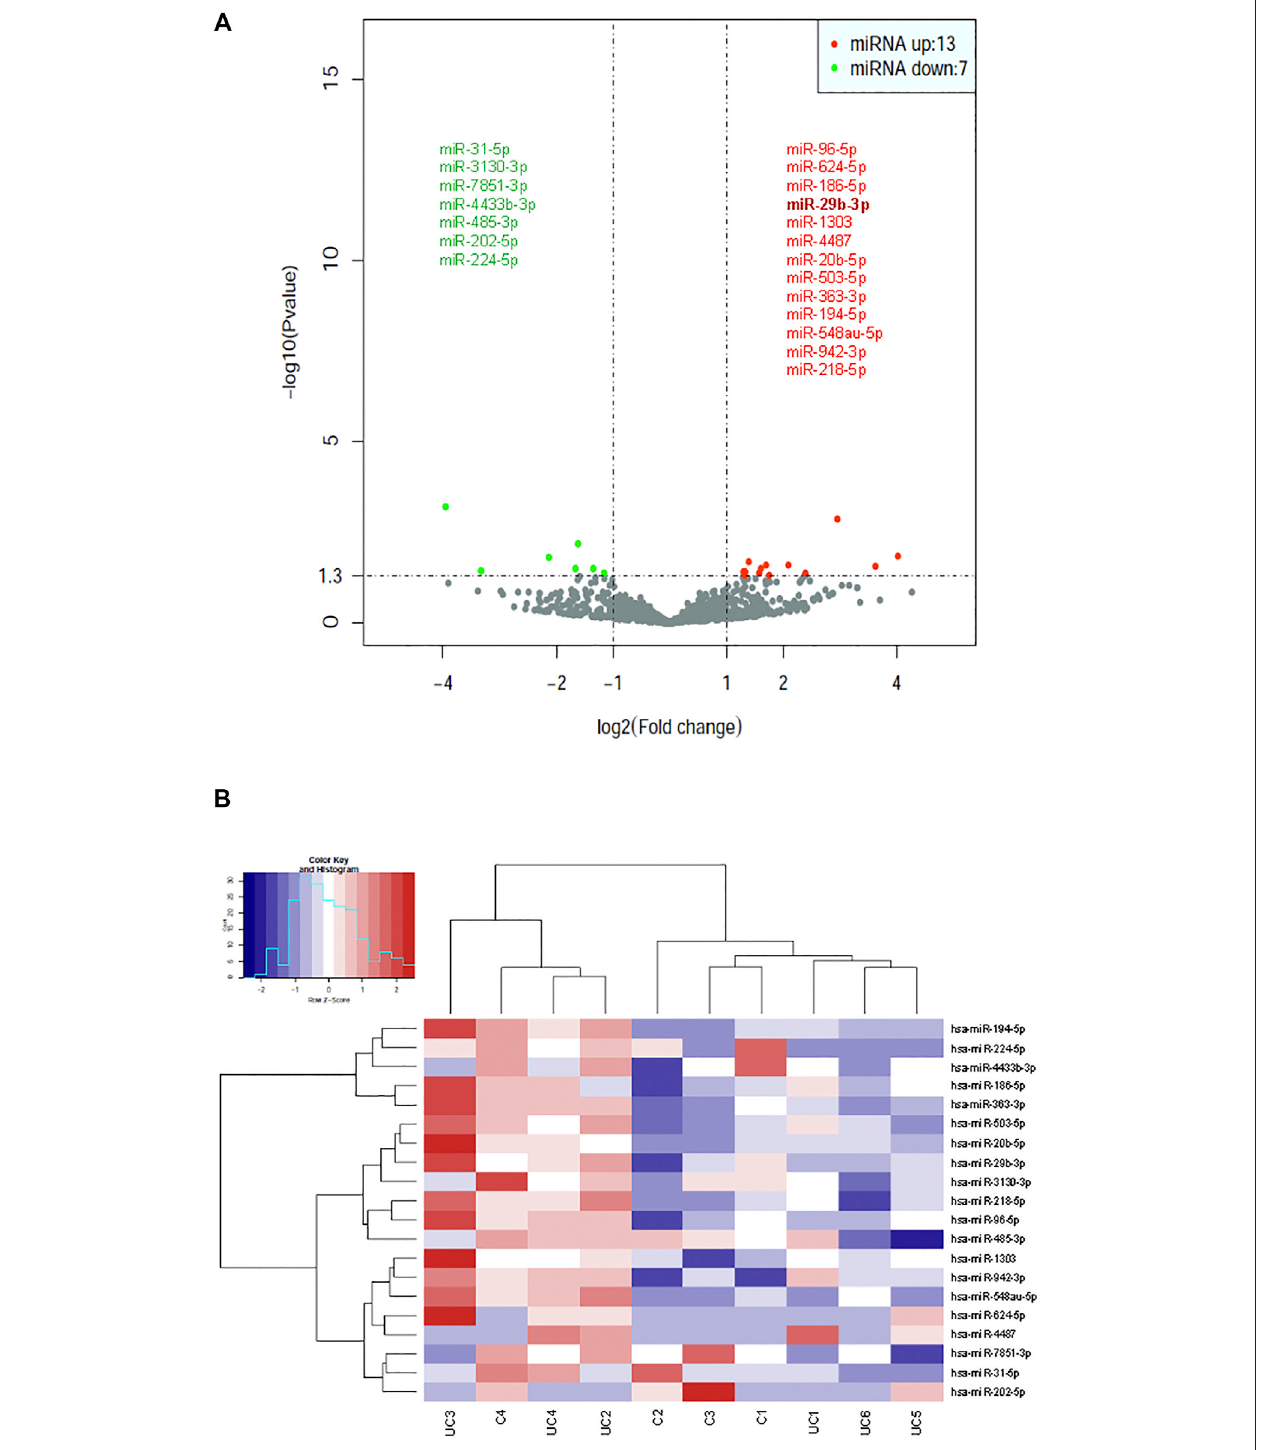
FIGURE 2 | Identi fi cation of dysregulated exosomal miRNAs in patients with UC by statistical analysis of small RNA-seq data. (A) Volcano plot representation of differential expression analysis of miRNAs in patients with UC vs healthy control subjects. The miRNAs are colored if they pass the thresholds for p value and log fold change, red if they are upregulated and green if they are downregulated. (B) Hierarchical clustering of normalized exosomal miRNA levels for the 20 miRNAs having statistical signi fi cance for differential expression between UC patients and control subjects.